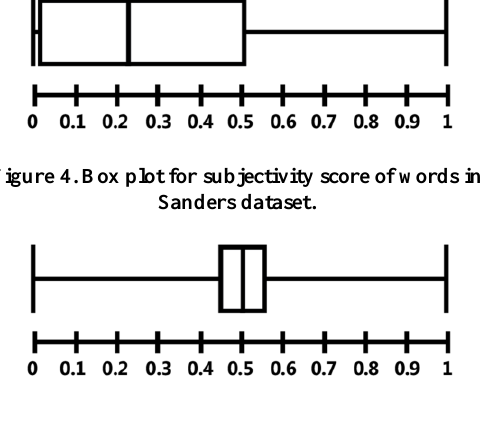
Figure 5. Box plot for subjectivity score of words in SemEval